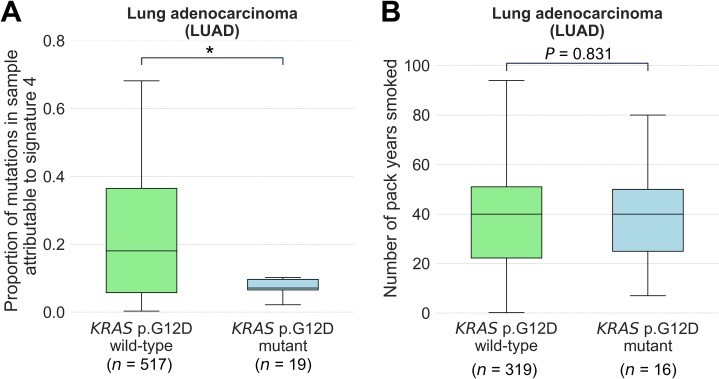
Association of KRAS p.G12D driver mutation with mutational signature 4 and with pack years smoked by people with lung adenocarcinoma.(A) Proportion of mutations attributable to signature 4 in lung adenocarcinoma (LUAD) tumours that are wild-type and mutant for KRAS p.G12D. (B) Number of pack years smoked by people with LUAD who have a previous history of smoking, in tumours that are wild-type and mutant for KRAS p.G12D. Box plots show median and quartiles, with significance by two-sided Mann Whitney U-Test in (A) and unpaired t-test in (B). * denotes P < 0.05.